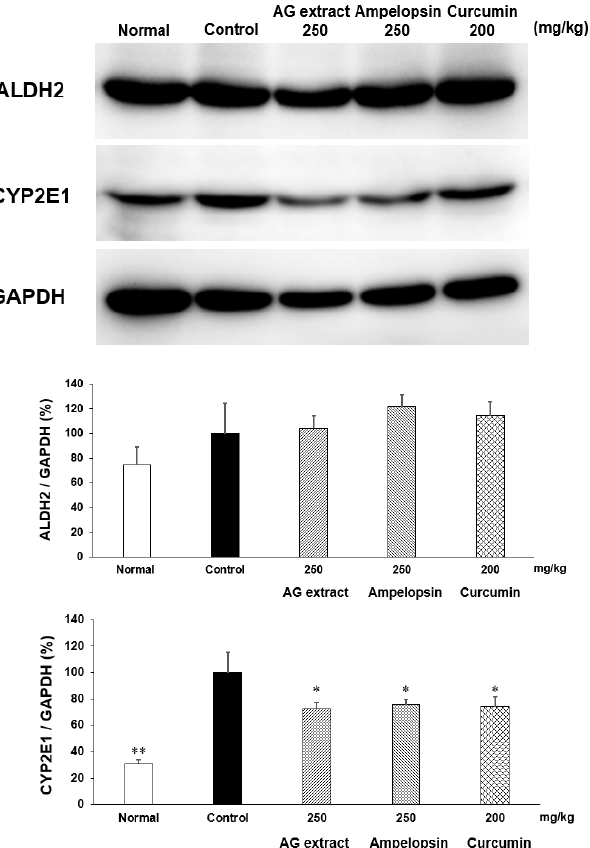
Figure 8. Effects of AG extract and ampelopsin on ALDH2 and CYP2E1 protein expression in the liver of alcohol diet-fed mice. Each column represents the mean ± SE ( n = 3–4). Data were assessed by a one-way analysis (ANOVA) of variance followed by Dunnett’s method. Asterisks denote significant differences from the control group at * p < 0.05, ** p < 0.01.